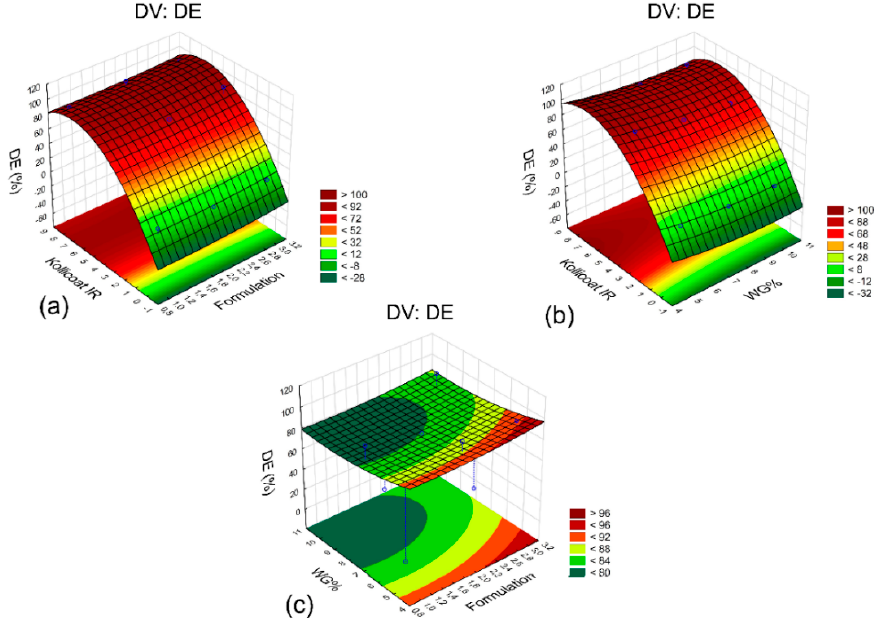
Figure 3. Response surface graphs for DE%, a dependent variable: ( a ) Kollicoat ® IR versus formula- tion; ( b ) Kollicoat ® IR versus WG%; ( c ) WG% versus formulation.